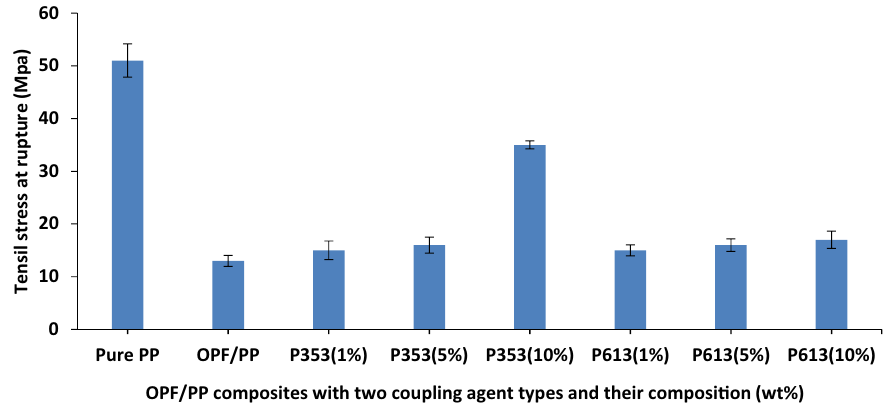
Figure 3: Tensile stress at rupture of the pure PP, uncoupled, and coupled 20% OPF/PP polymer composite with two coupling agent types of di ff erent weight